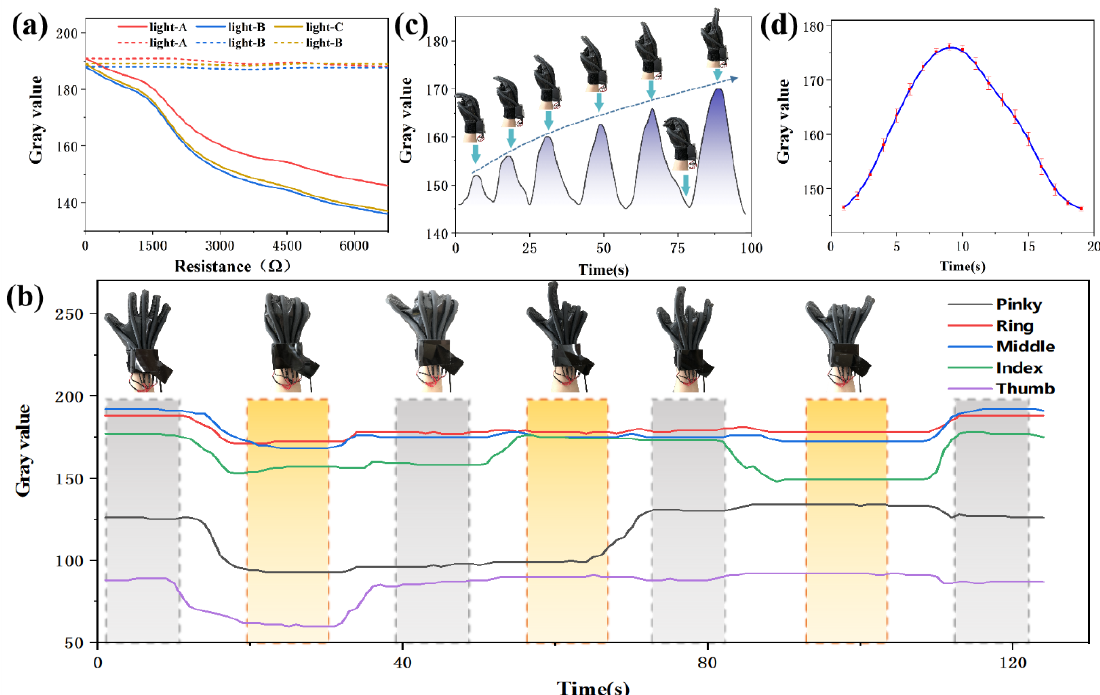
Figure 7. ( a ) Comparison between the brightness of the optical source without reference fiber and the brightness of the optical source after self-compensation processing during use. ( b ) Gray value curves of elastic fibers of five fingers under six consecutive different gestures. ( c ) The index finger is bent 6 times of different amplitude, and the bending radius is gradually increased until it is completely straight. ( d ) The average gray value curve of the index finger in the process of repeatedly bending and stretching 50